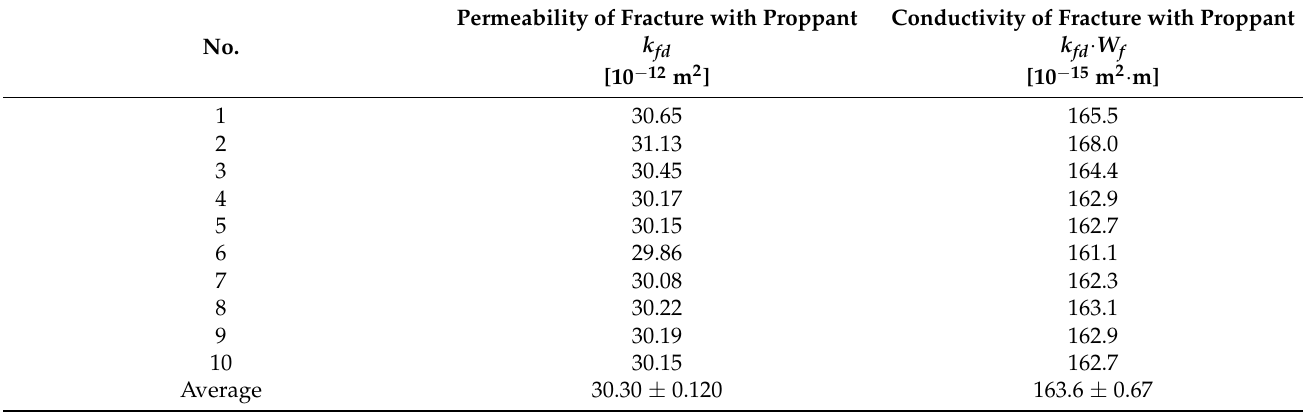
Table 10. The measurement results for the determination of the original conductivity and permeability of the fracture filled with light ceramic proppant 20/40 damaged by the fluid FF2A at 60 ◦ C; compressing stress 41.4 MPa.